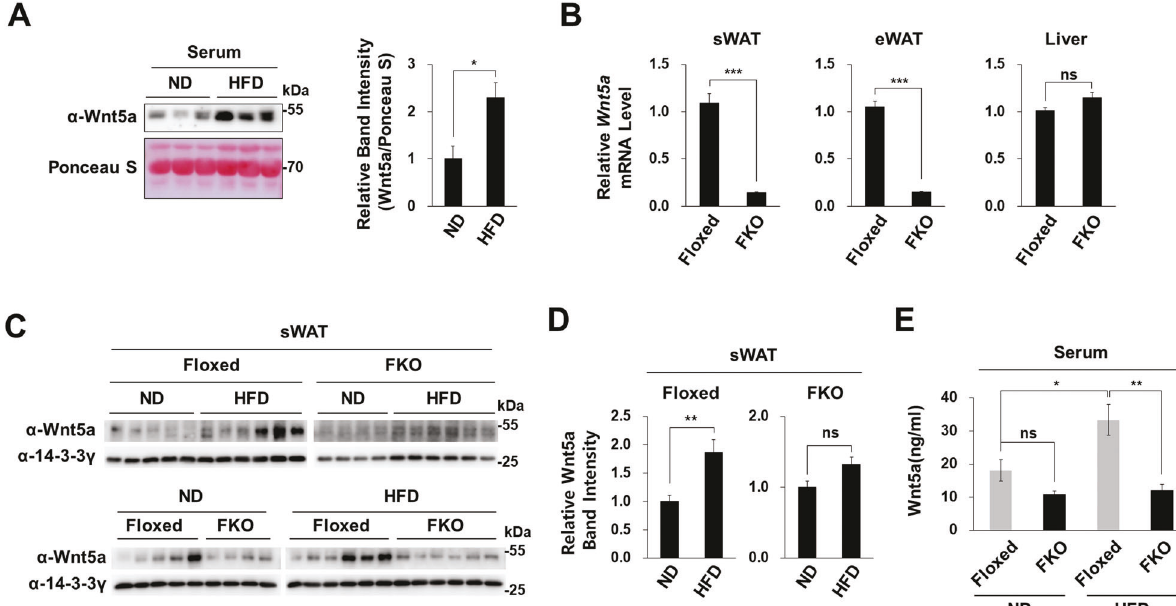
Fig. 6 Obesity and Wnt5a expression in fat speci fi c Wnt5a knock-out mice. A Western blot analyses of Wnt5a protein in mouse serum (left panel). Ponceau S staining was performed to con fi rm equal loadings. Serum was obtained from the hearts of three male C57BL/6 J mice fed the ND or the HFD for 20 weeks from 8 weeks old. Relative band intensities of Wnt5a were obtained using ImageJ software and normalized versus Ponceau S band intensities (right panel). B – D Fat speci fi c Wnt5a knock out (FKO) mice were generated by disrupting Wnt5a exon 2, as described in Supplementary Fig. S1A. B qRT-PCR of Wnt5a mRNA levels normalized versus 18 S rRNA levels in liver, subcutaneous WATs, or epididymal WATs of male Wnt5a fl / fl mice (Floxed), and male FKO mice fed the ND for 20 weeks from 8 weeks old (Floxed 20 w ND, n = 5; FKO 20 w ND, n = 4). C Western blot analyses of Wnt5a protein in the sWATs of Floxed and FKO mice fed the ND or the HFD for 20 weeks from 8 weeks old. 14-3-3 γ was used as the loading control. D Relative band intensities of Wnt5a were determined using ImageJ software and normalized versus 14-3-3 γ band intensities. E Concentration of Wnt5a protein in the sera of Floxed and FKO mice as determined using a Mouse Wnt5a ELISA kit (AVIVA). Floxed and FKO mice were fed the ND or the HFD for 20 weeks from 8 weeks old (Floxed ND, n = 5; Floxed HFD, n = 6; FKO ND, n = 4; FKO HFD, n = 6). The signi fi cances of differences were assessed using a two-tailed paired Student ’ s t -test. * p < 0.05, ** p < 0.01, *** p < 0.001; ns, not signi fi